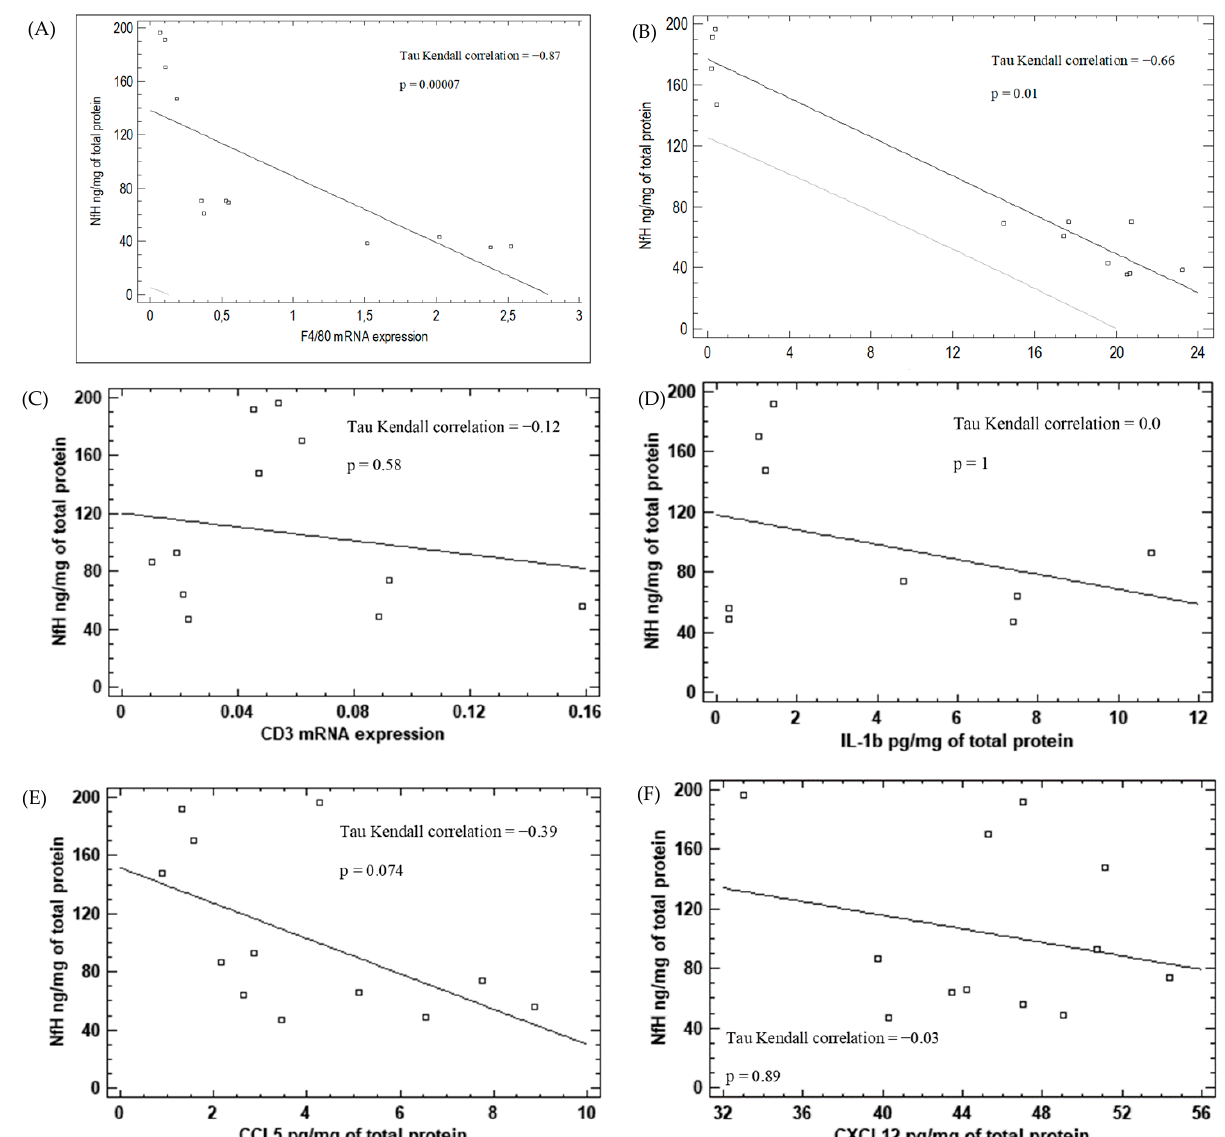
Figure 9. Correlation between monocyte/macrophage marker F4/80 ( A ), chemokine CXCL2 ( B ), T-cell-line marker CD3 ( C ), cytokine IL-1 β ( D ), chemokine CCL5 ( E ), chemokine CXCL12 ( F ) and neurodegeneration marker NfH in KA-injected brain